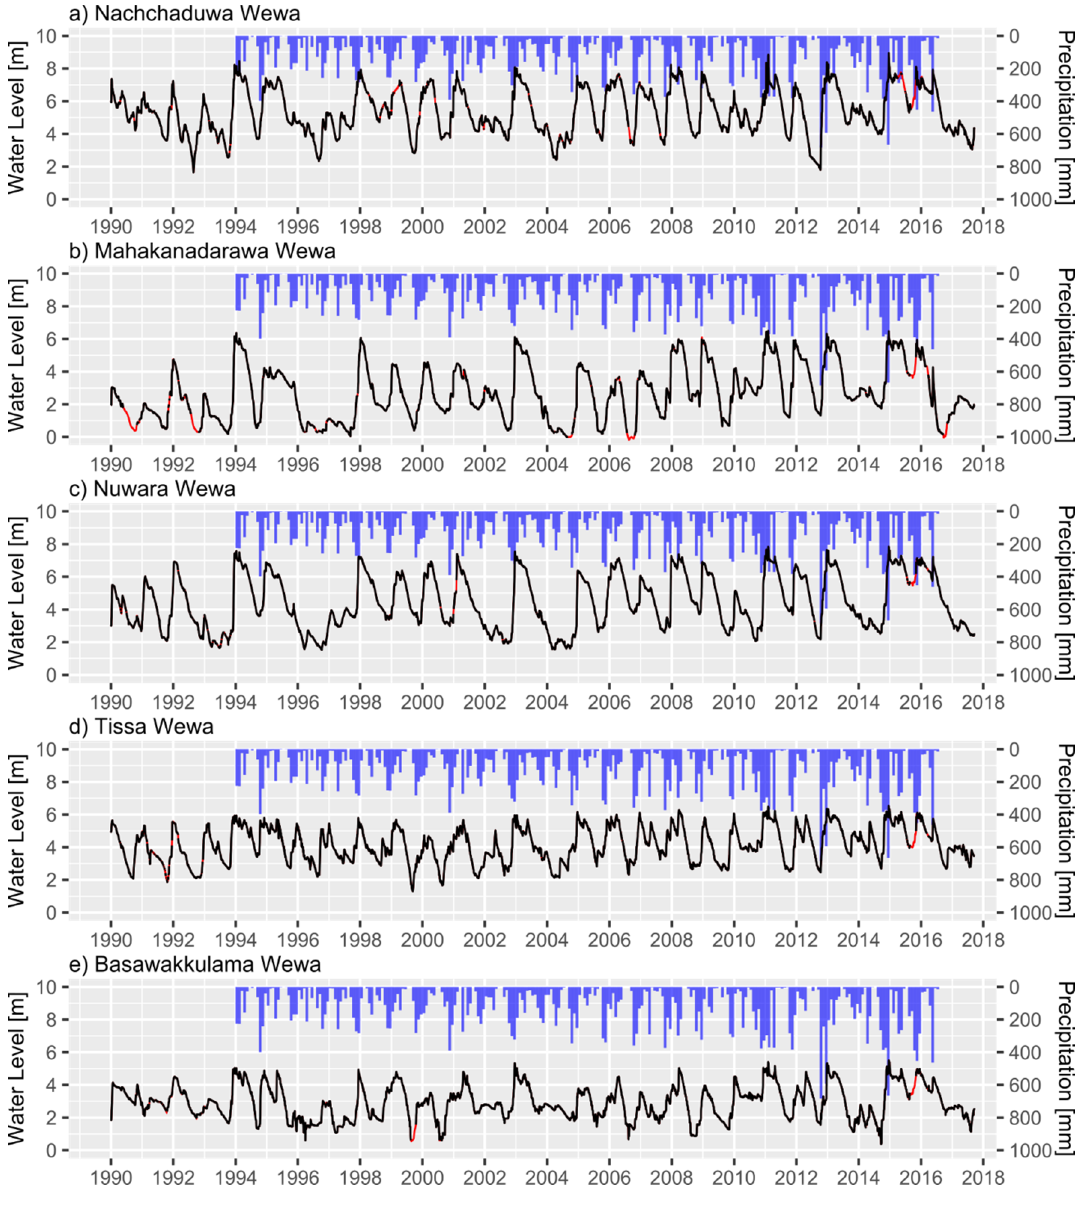
Figure 3. Daily water level of the five investigated major tanks: ( a ) Nachchaduwa Wewa, ( b ) Mahakanadarawa Wewa, ( c ) Nuwara Wewa, ( d ) Tissa Wewa, ( e ) Basawakkulama Wewa and monthly precipitation for Anuradhapura meteorological station (black line = original values, red line = interpolated values, blue bars = monthly precipitation values).